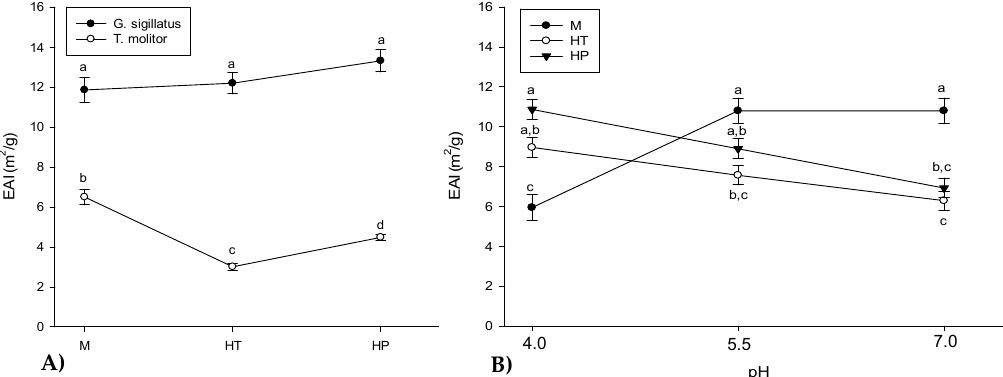
Figure 2. Emulsion activity index (EAI) of insect meals (M) and hydrolysates (HT: control hydrolysate, HP: hydrolysate generated by HHP treatment of meal prior to enzymatic hydrolysis) according to the insect source (cricket and mealworms) ( A ) and according to the pH (4.0–7.0) ( B ). Di ff erent letters indicate significant di ff erence ( p <